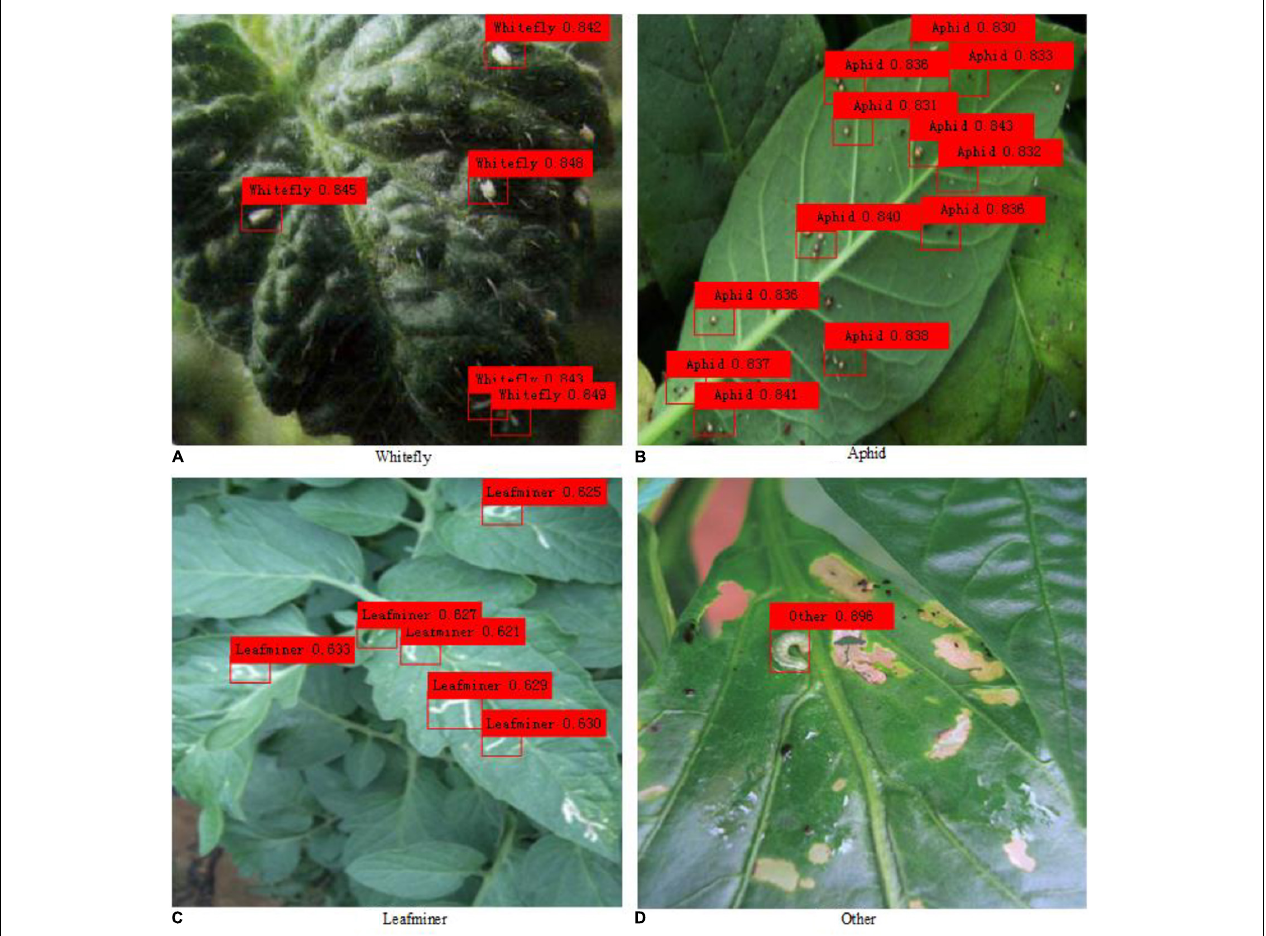
FIGURE 7 | Detection effect of practical images of healthy and unhealthy objects.